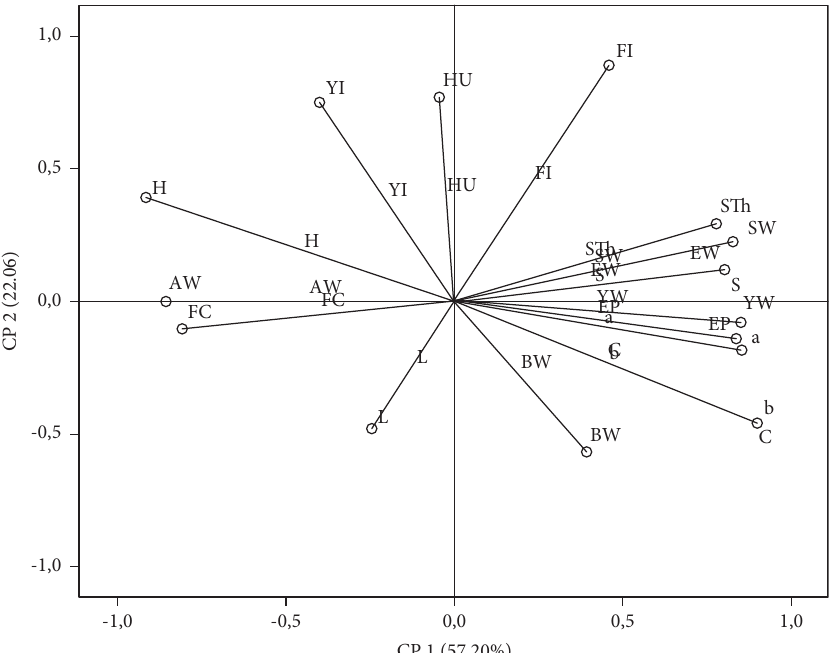
Figure 1: Projection of zootechnical performance, physical egg quality, and yolk color measurement in the plane defned by two principal components. YW: yolk weight; AW: albumen weight; a ∗ : redness; H ∗ : hue angle; b ∗ : yellowness; C ∗ : chromaticity; EP: egg production; ST: shell thickness; EW: egg weight; S: surface; FC: feed consumption; SW: shell weight; HU: haugh unit; YI: yolk index; FI: feed index; and BW: body weight.